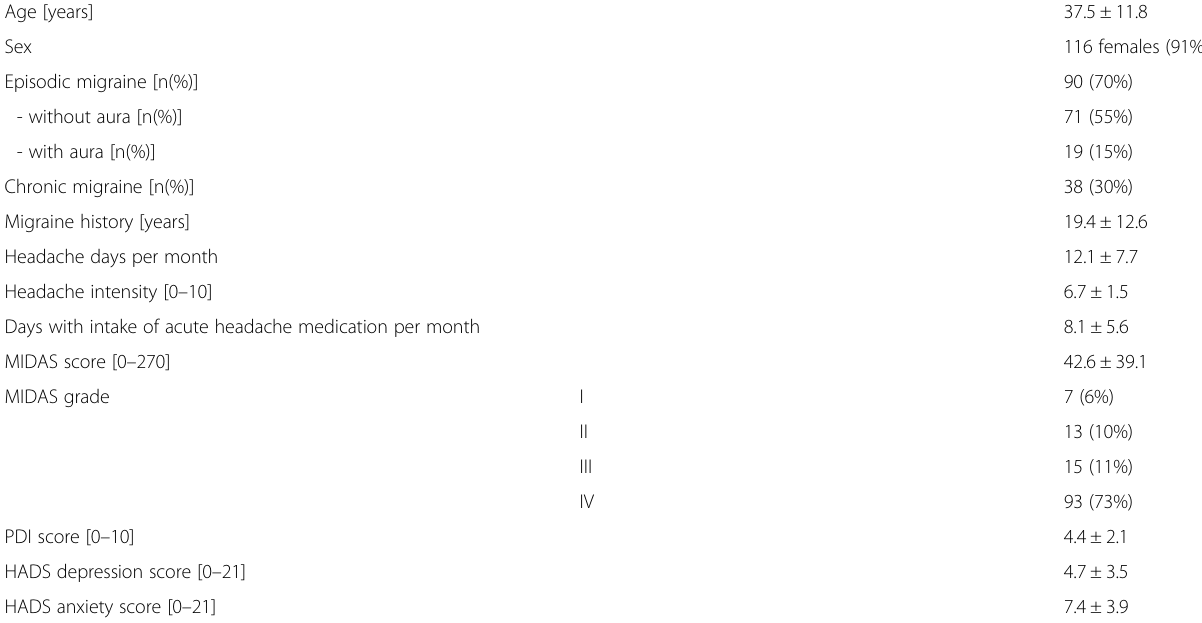
Table 1 Characteristics of the study population ( n = 128) Age [years] Episodic migraine